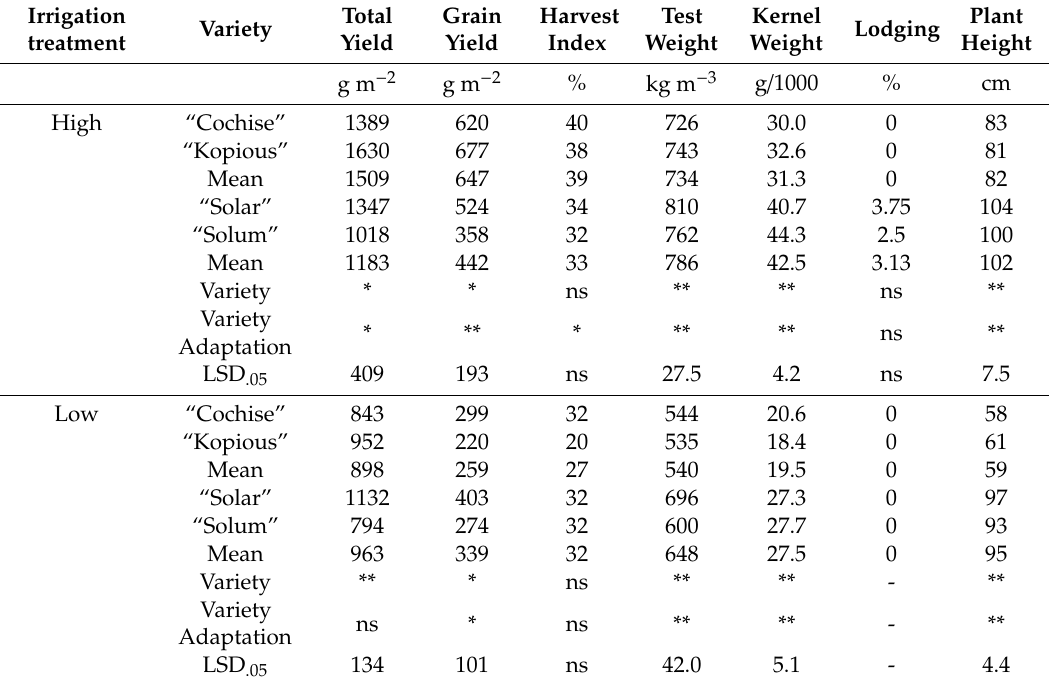
Table 7. E ff ect of irrigation treatment on barley yield and yield components for a trial conducted in Tucson in 2018. Irrigation treatment